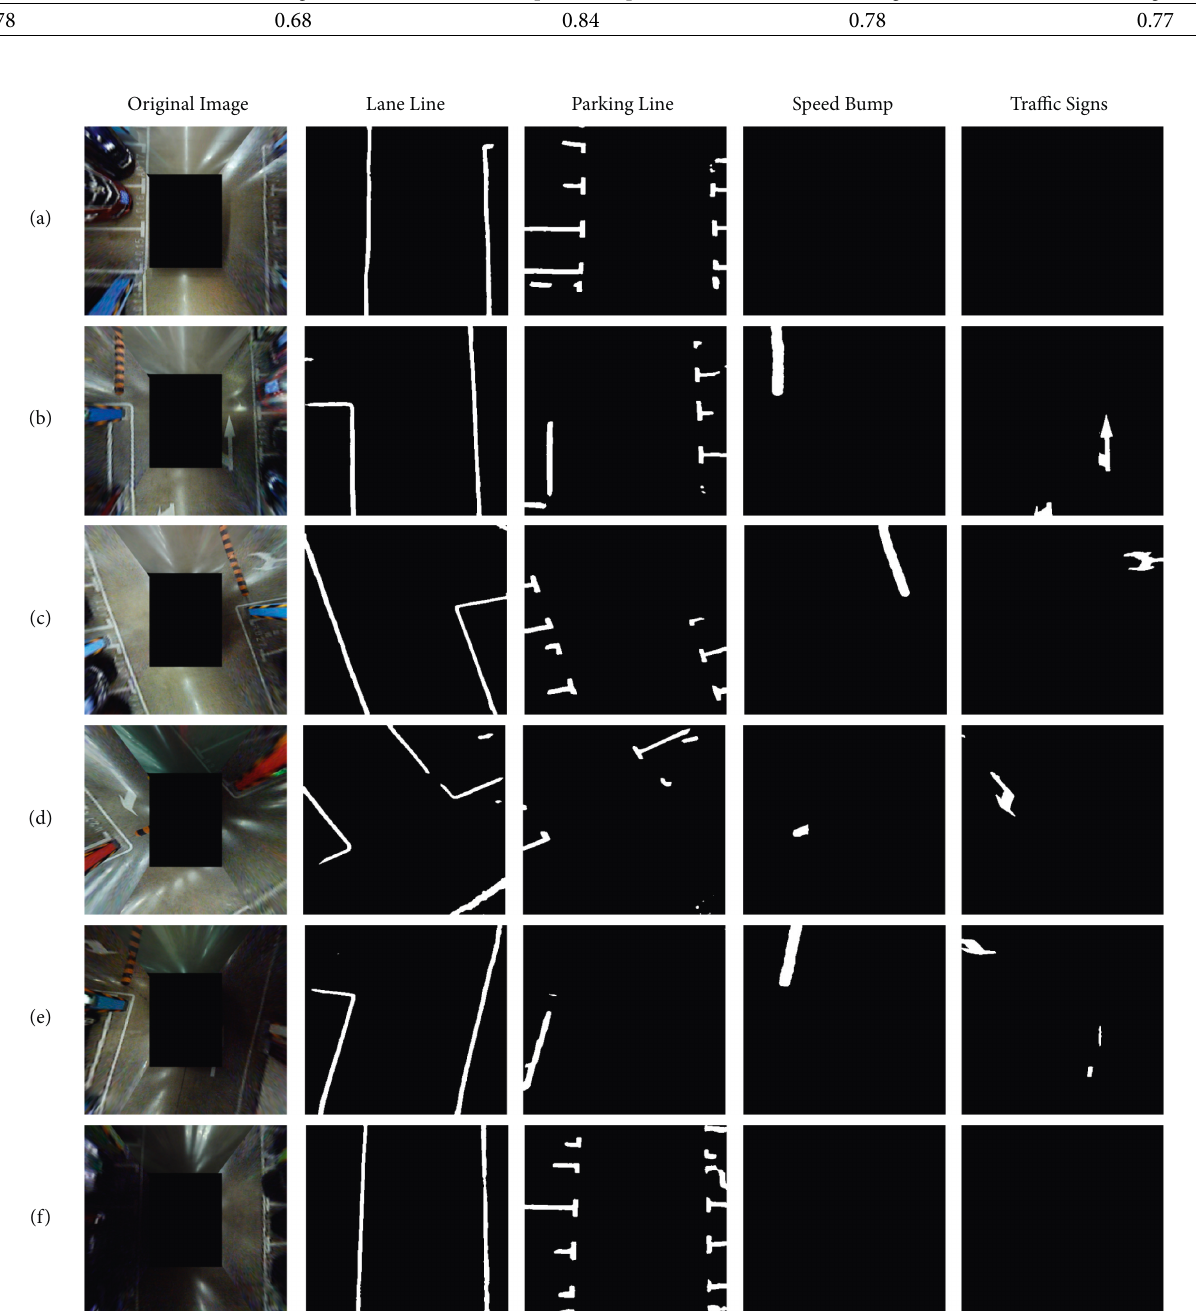
Figure 13: Semantic segmentation